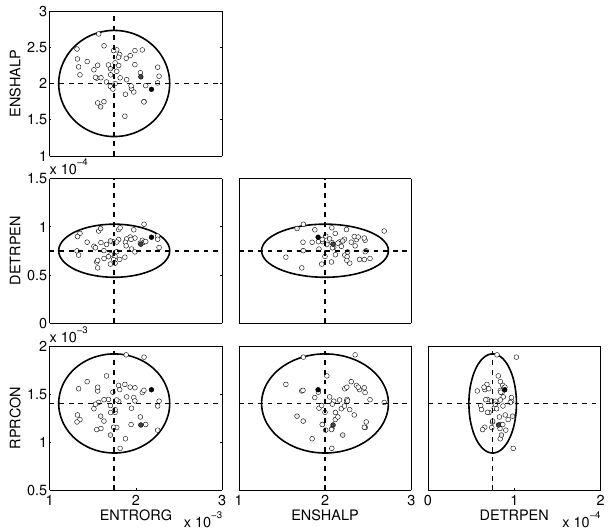
Fig. 2a. Pair-wise parameter covariances at the initial time. De- fault parameter values ( µ 0 ) are denoted by dashed lines. The ellipse represents the prior parameter uncertainty as specified initially (the 95% probability range of the parameter uncertainty 6 0 ) . The small markers are the proposed parameter values at the first step; darkness of color is indicative of the weights given to re-sampled parameter values.